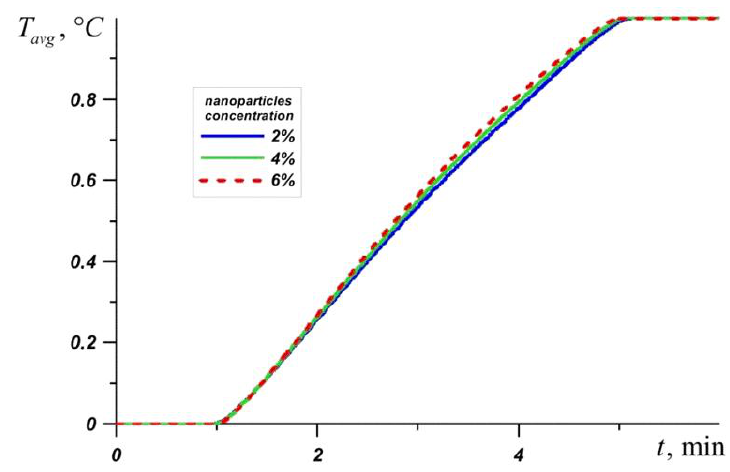
Figure 6. Liquid volume fraction versus time for lauric acid.